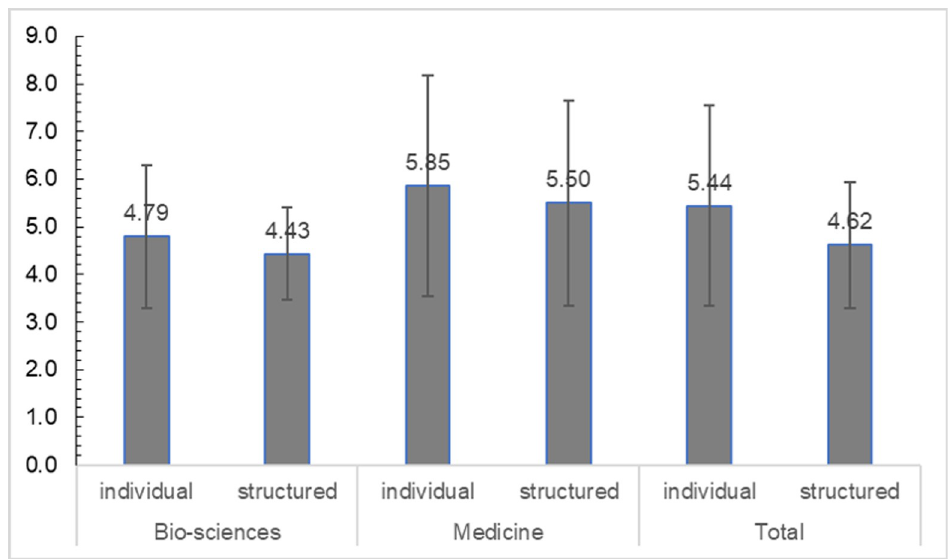
Fig 1. Mean duration of respondents’ doctoral education in years (from start of work to graduation). a T = 3.69, p < 0.001; b T = 1.13, p = 0.263; c T = 7.14, p < 0.001; N = 1522.